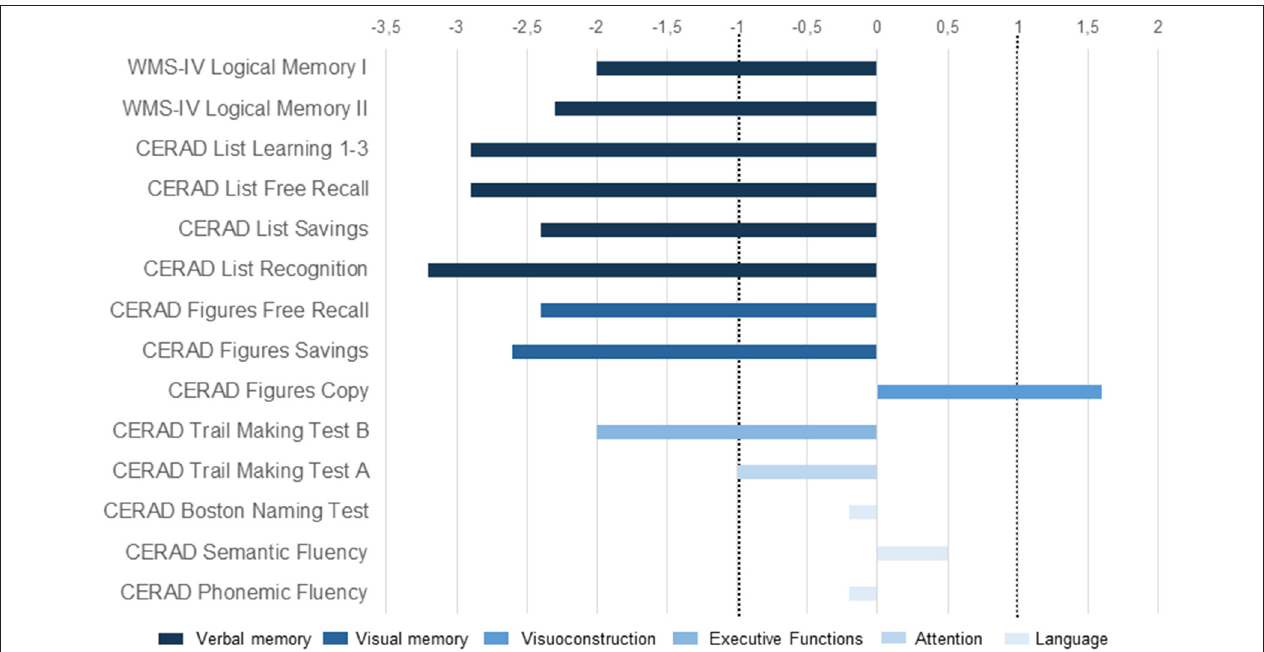
FIGURE 1 | Cognitive profile (clinical case with neurochondrin antibodies in association with AD dementia). Illustration of neuropsychological test results presented as z-scores. The area between dotted lines denotes the normal range. CERAD, Consortium to Establish a Registry for Alzheimer’s Disease; WMS-IV, Wechsler Memory Scale–Fourth